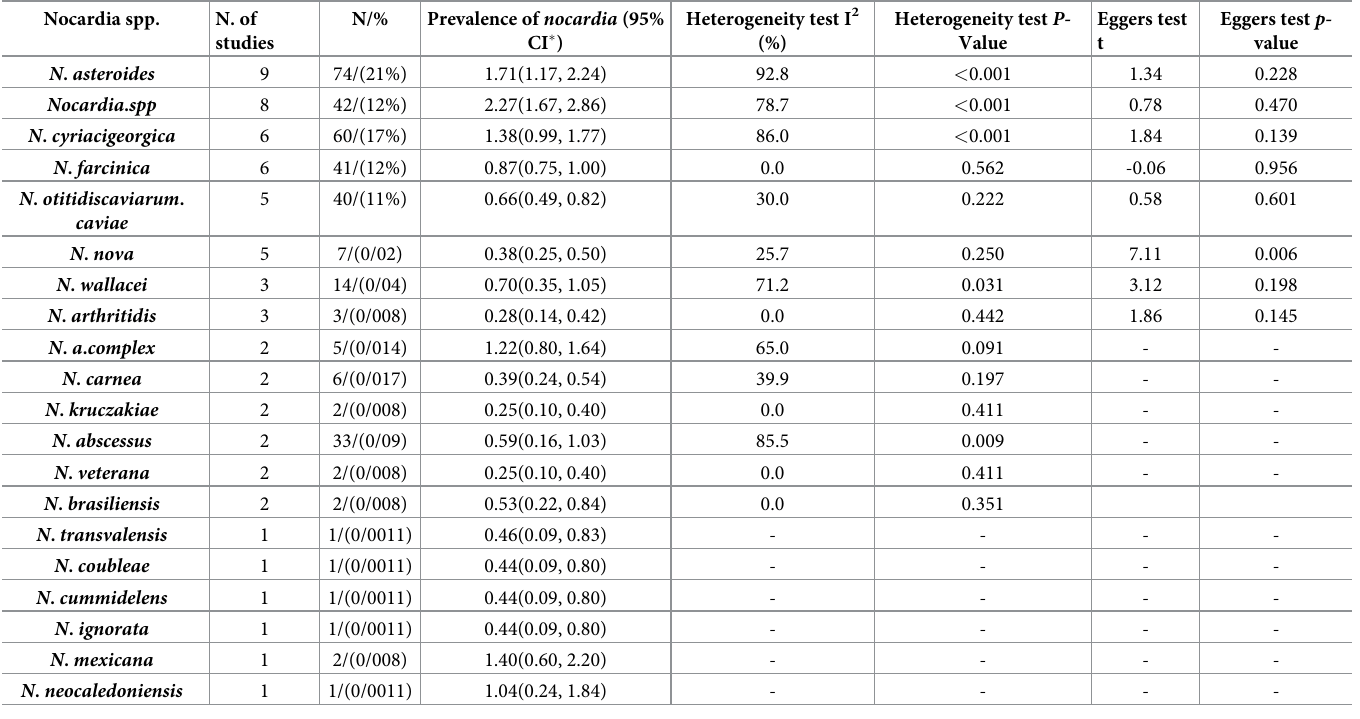
Table 2. Nocardia spp. distribution among Iranian studies. Nocardia